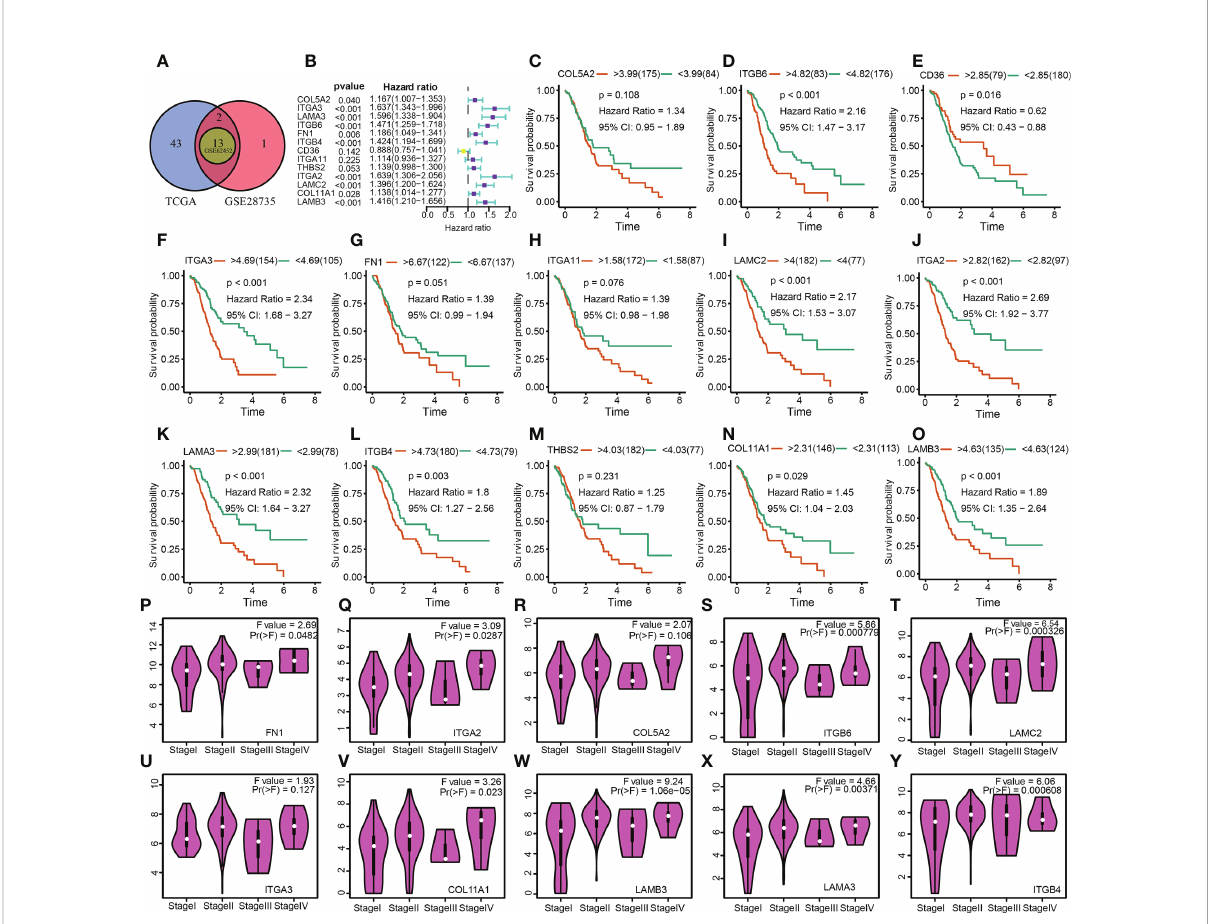
FIGURE 3 Determination of differentially expressed ECM-related genes, their prognostic signi fi cance, and their relationship with the tumor stage of PAAD. (A) A Venn diagram revealed 13 ECM-related genes that were differently expressed between PAAD and normal pancreatic tissues. (B) The analysis illustrated the prognostic signi fi cance of 13 differentially expressed ECM-related genes in PAAD. (C – O) Survival analysis of 13 ECM- related genes. (P – Y) The relationship between 10 ECM-related genes and the tumor stage of